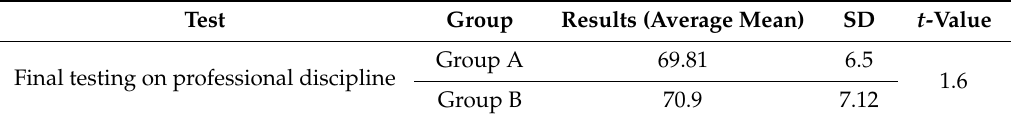
Table 2. Descriptive statistics (professional discipline